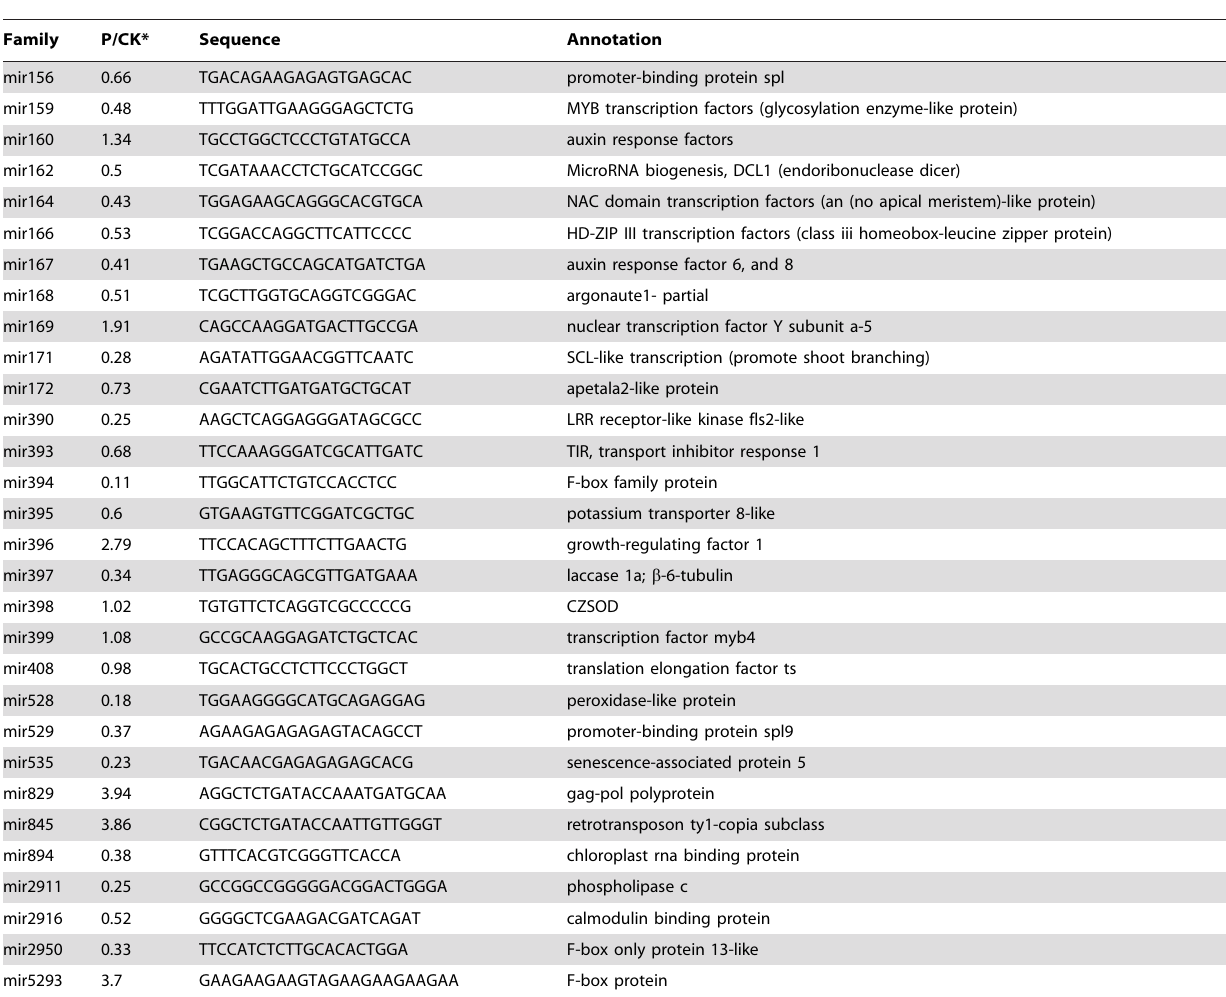
Table 3. Target genes prediction for miRNAs in P. indica colonized- Oncidium roots.